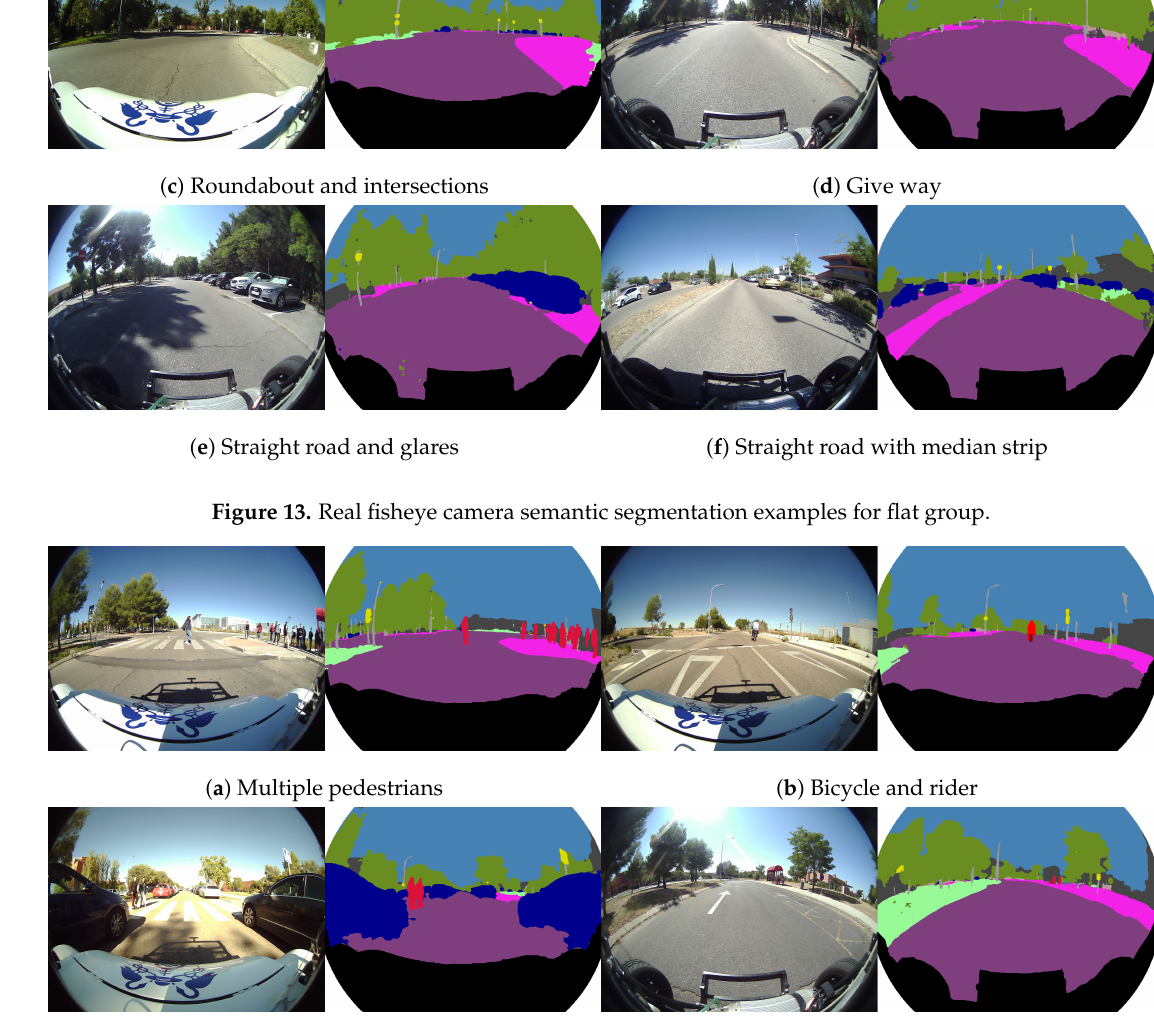
Figure 14. Real fisheye camera semantic segmentation examples for the human